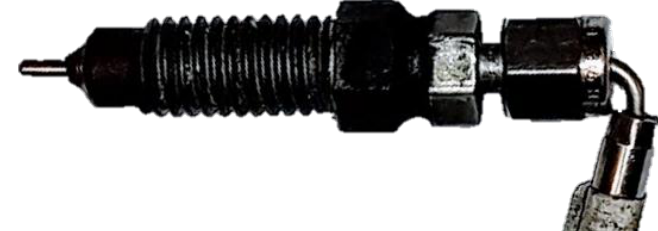
Figure 7. A modified bleeding screw for measuring brake fluid temperature.